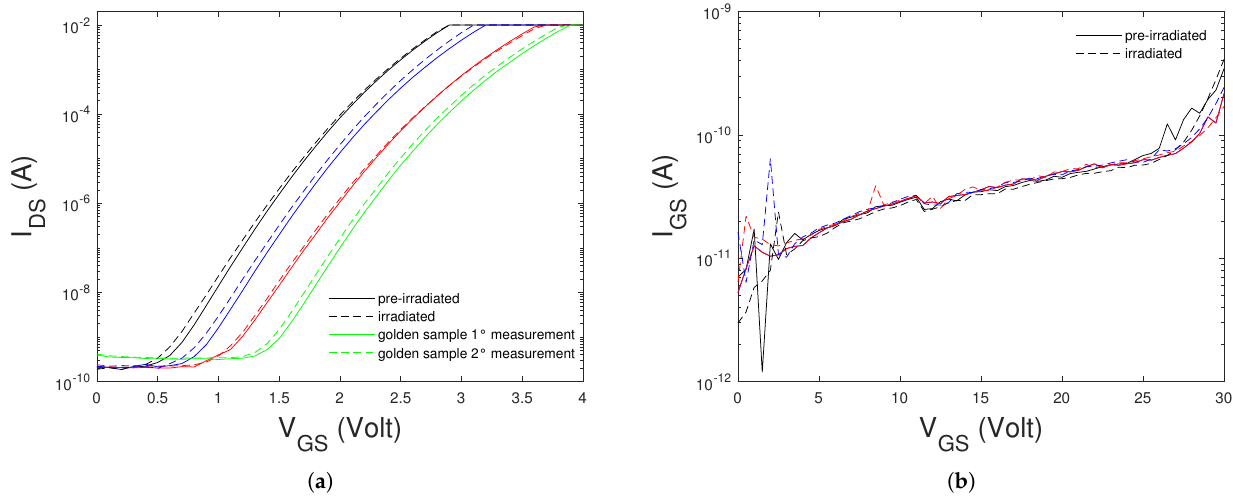
Figure 1. Sub − threshold ( a ) and Fowler-Nordheim ( b ) curves of three samples of the GEN3 SiC MOSFET before and after neutron irradiation. Two sub − threshold curves of a golden smaple are also